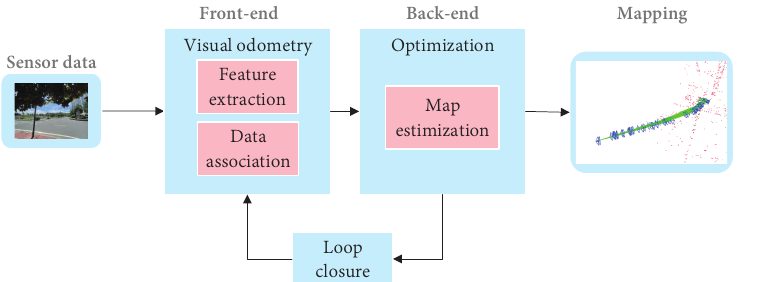
Figure 9. The typical visual SLAM system framework.